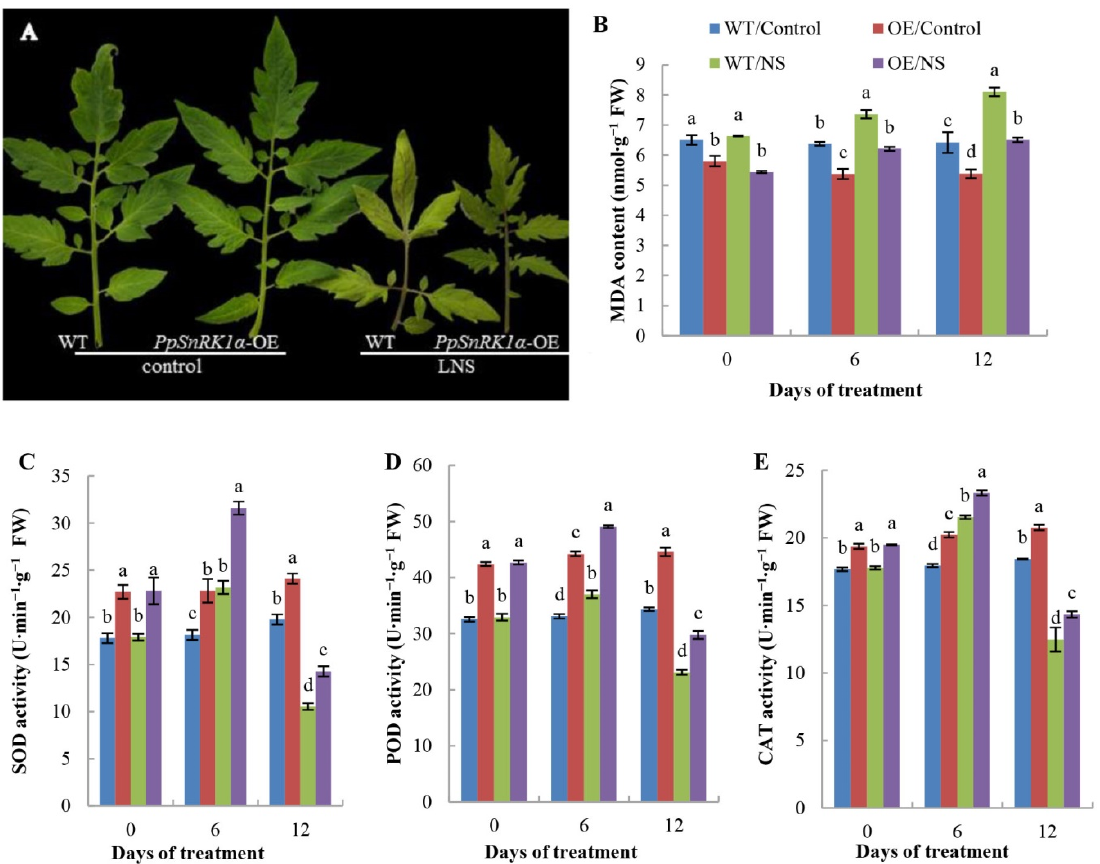
Figure 2. Response of wild-type (WT) and PpSnRK1 α -overexpressing (OE) plants to low nutrient stress (LNS). ( A ) Phenotypes of the third functional leaf from the top of tomato plants after 12 days of treatment. ( B – E ) The MDA content ( B ), SOD ( C ), POD ( D ) and CAT ( E ) activities in the leaves of WT and OE lines. Values are the mean ± SD of triplicate samples. Different lowercase letters on the same days of treatment indicate significant differences according to Duncan’s multiple range test ( p <